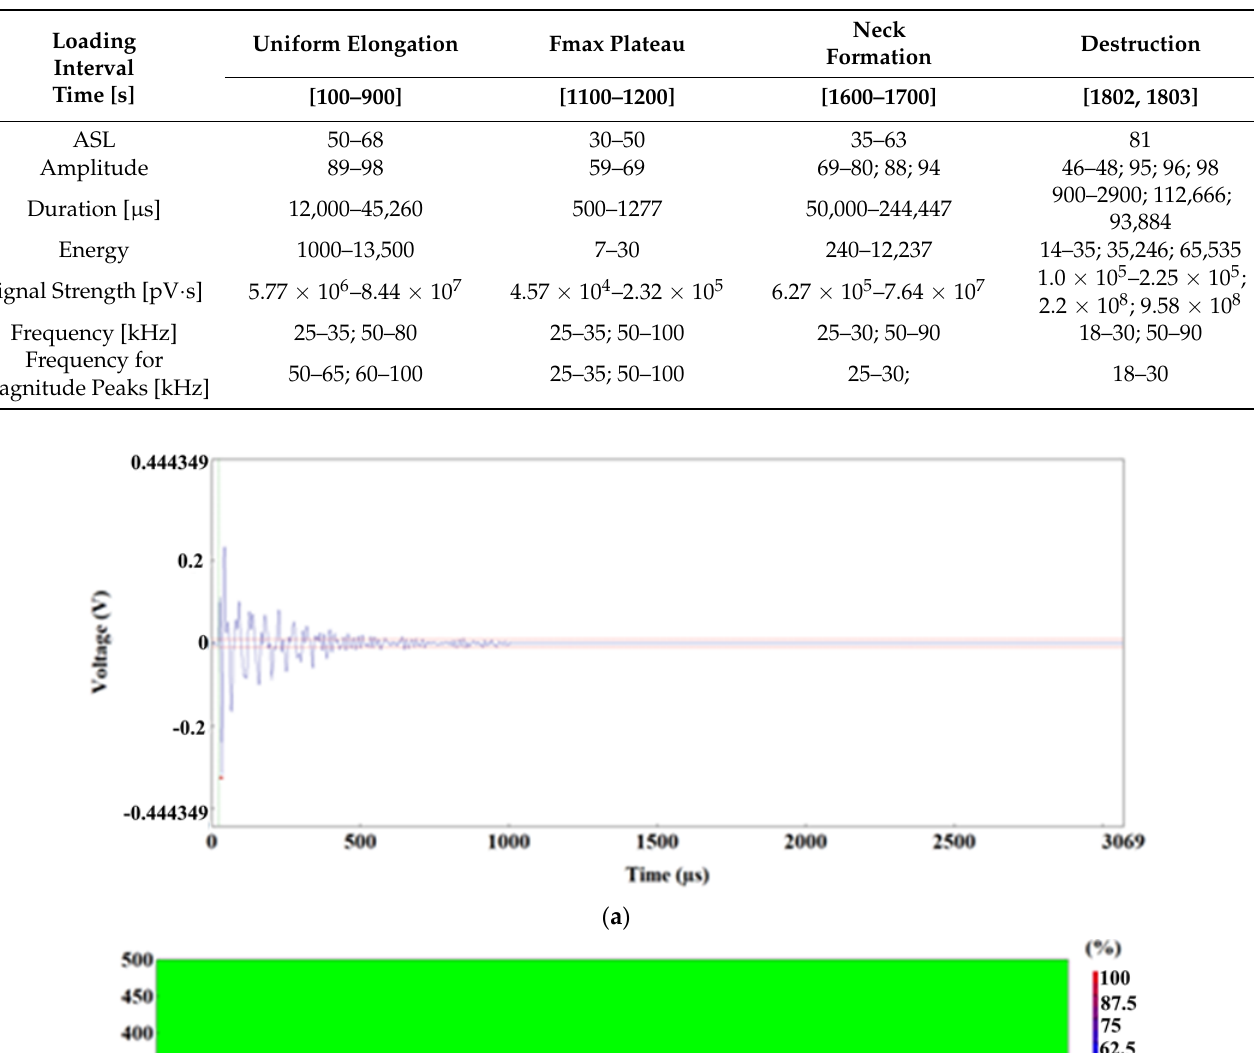
Table 3. Characteristics of the parameters and frequency ranges of AE signals at respective stages of specimen loading.